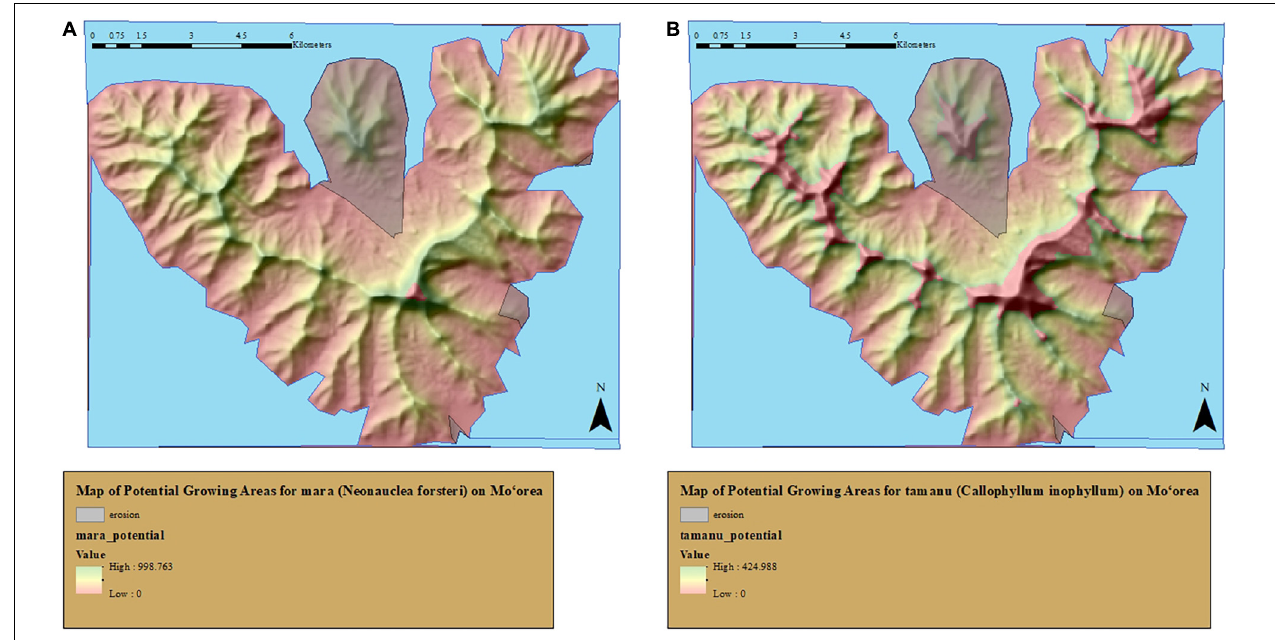
FIGURE 6 | (A) Visual habitat suitability model for Tamanu on the Island of Mo‘orea; (B) visual habitat suitability model for Mara on the island of Mo‘orea.